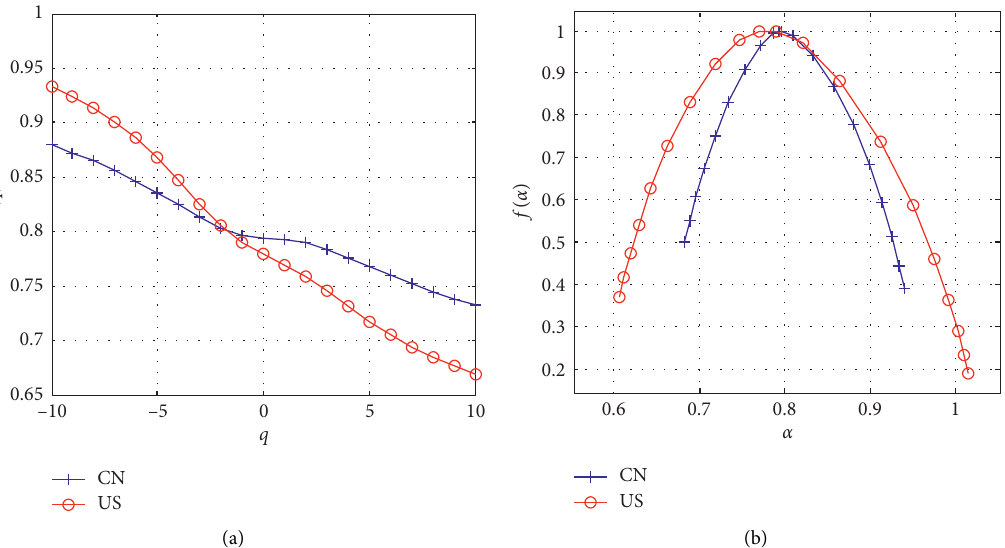
( s ) and s for (a) China and (b) USA. q